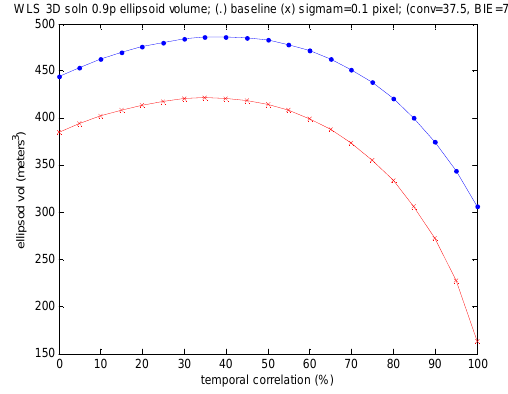
Figure 15. Predicted error ellipsoid volume vs. temporal